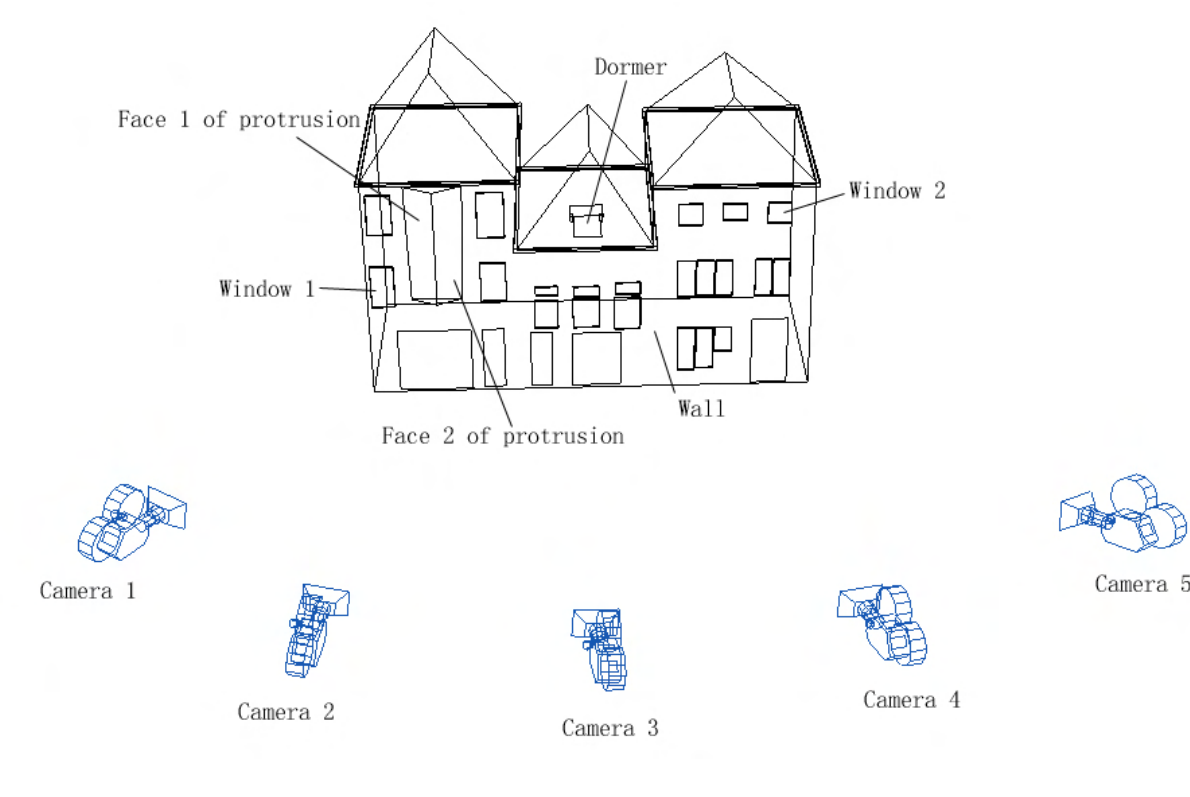
Figure 10. Choosing the optimal texture images for different model parts.